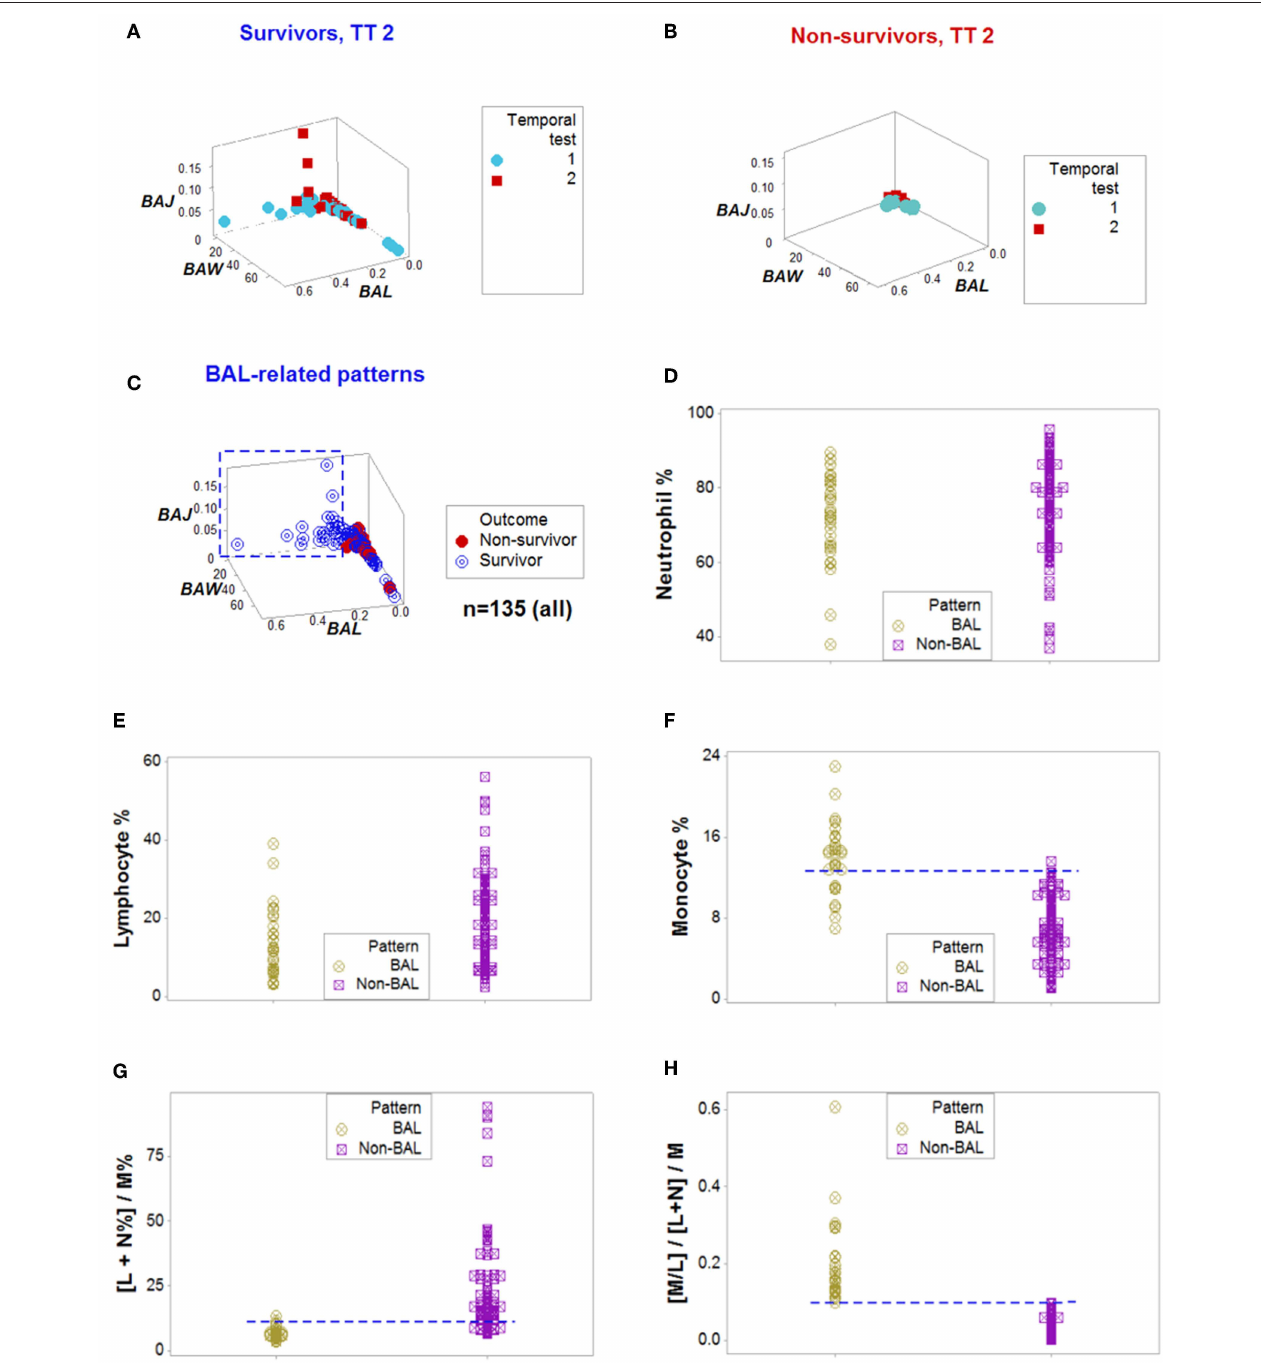
FIGURE 2 | From pattern detection to biological validation. When spatial and temporal patterns were considered, as well as outcomes, emergent and non-random patterns were noticed since temporal test (TT) 2 (A,B) . While survivors displayed a perpendicular data departure at TT2 (A) , non-survivors exhibited observations with values ∼ 0, at TT 1 and 2 (B) . The survivor-only pattern remained at all later testing times (C) . Personalized discrimination could be conducted even when the number of observations was n = 1: any one data point located with the rectangle shown in (C) could be predicted to survive. Validation of these patterns was based on a series of analyses of increasing complexity, which included biologically interpretable indicators (D–H) . While neither the neutrophil (N) nor the lymphocyte (L) percentages exhibited different intervals between the BAL and non- BAL data subsets (D,E) , some differences emerged whern the monocyte (M) percentage was assessed: a horizontal line, shows that most survivors captured by the BAL pattern displayed a higher M percentage, although a substantial data overlapping remained (F) . Because the sum of L % and N % is 100– M%, when both the L and N% are included in the numerator of a ratio that measures M% in the denominator,